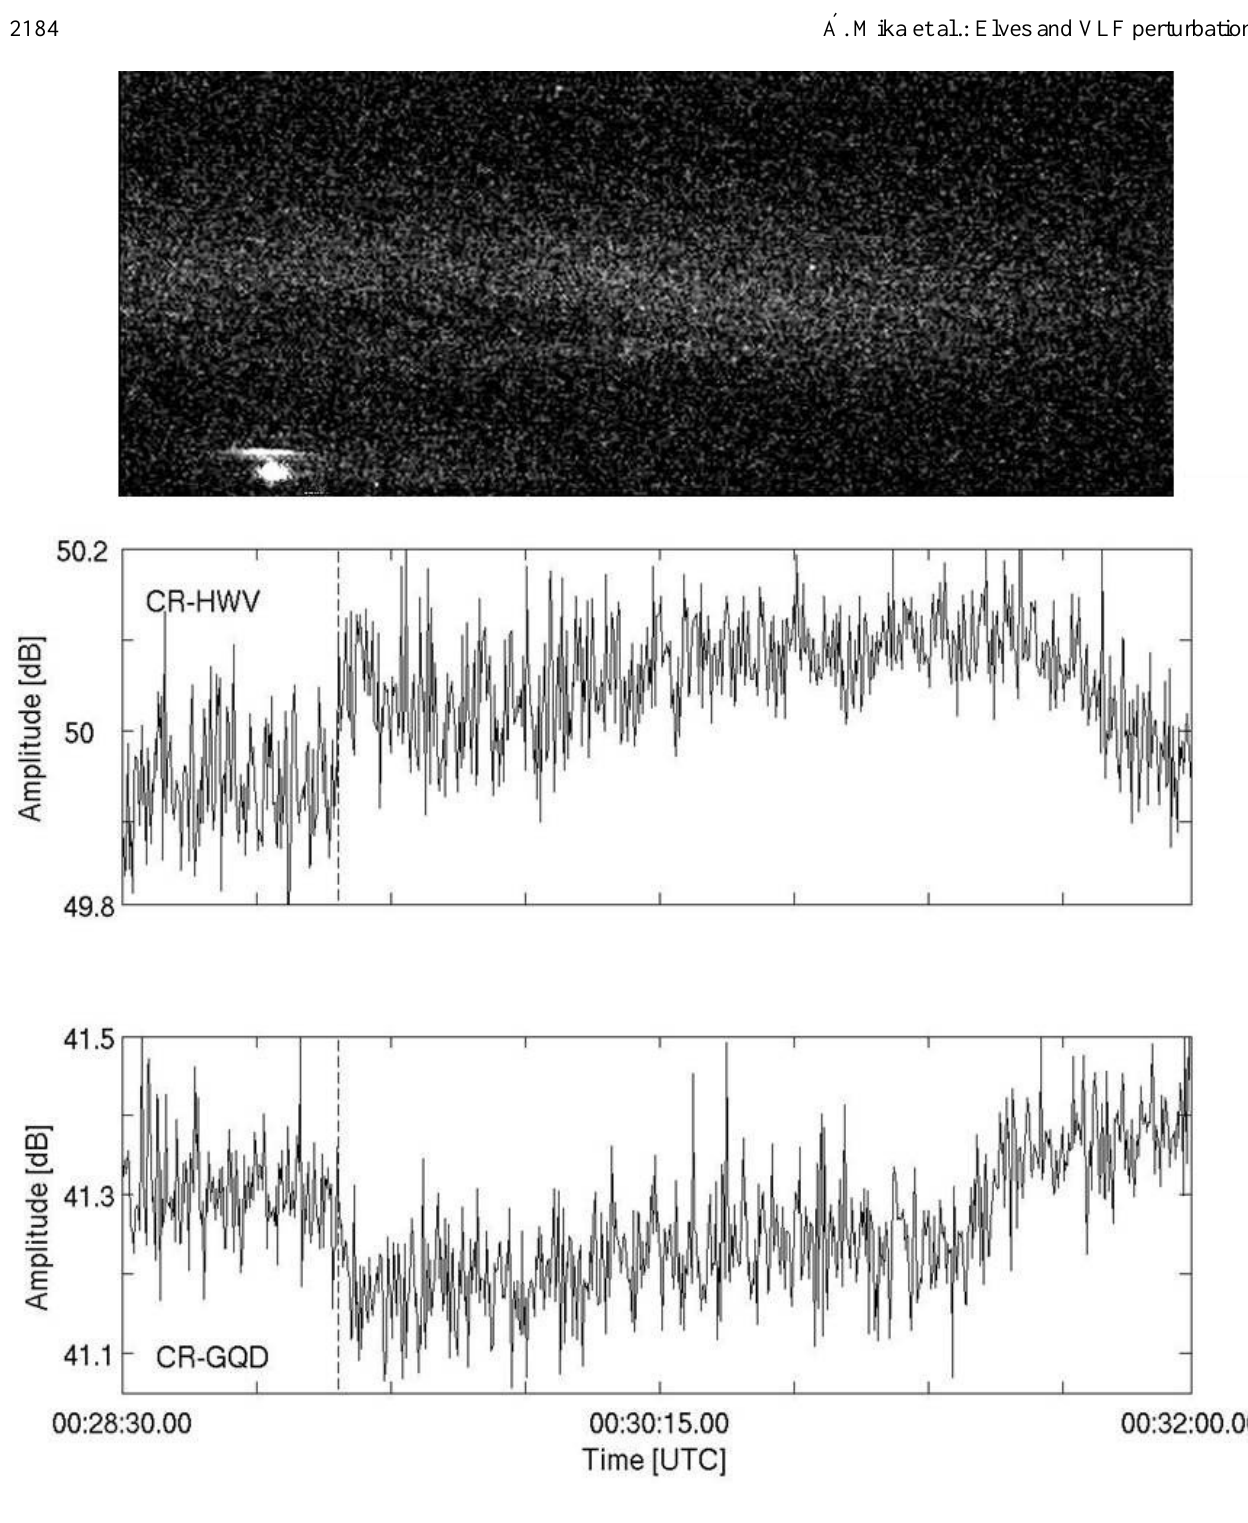
Fig. 3. Early VLF perturbations observed on the Crete–HWV (middle panel) and Crete–GQD (bottom panel) GCPs in association with the elve captured on 24 July 2003 at 00:29:12 . 757UTC (top panel). The vertical dashed lines mark the occurrence of the